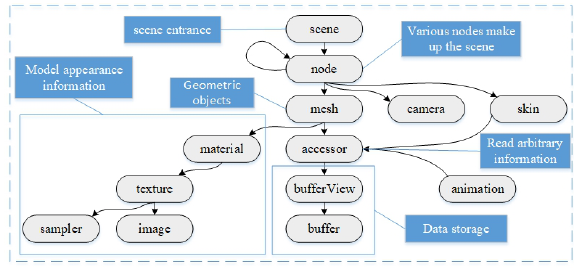
Fig. 2. The basic structure of the JSON file